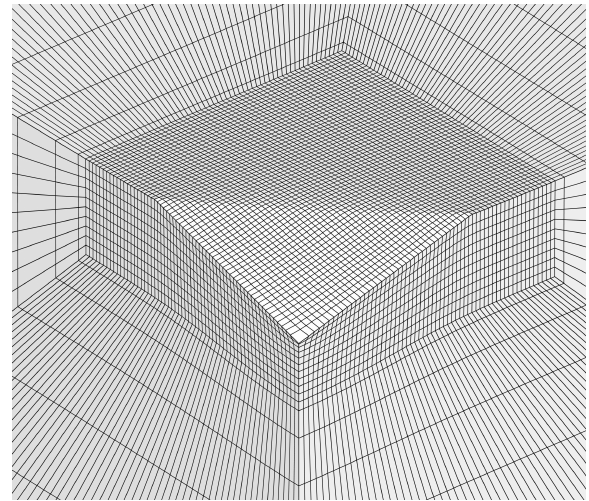
Figure 3. Three-dimensional mesh of a material surface with an indentation